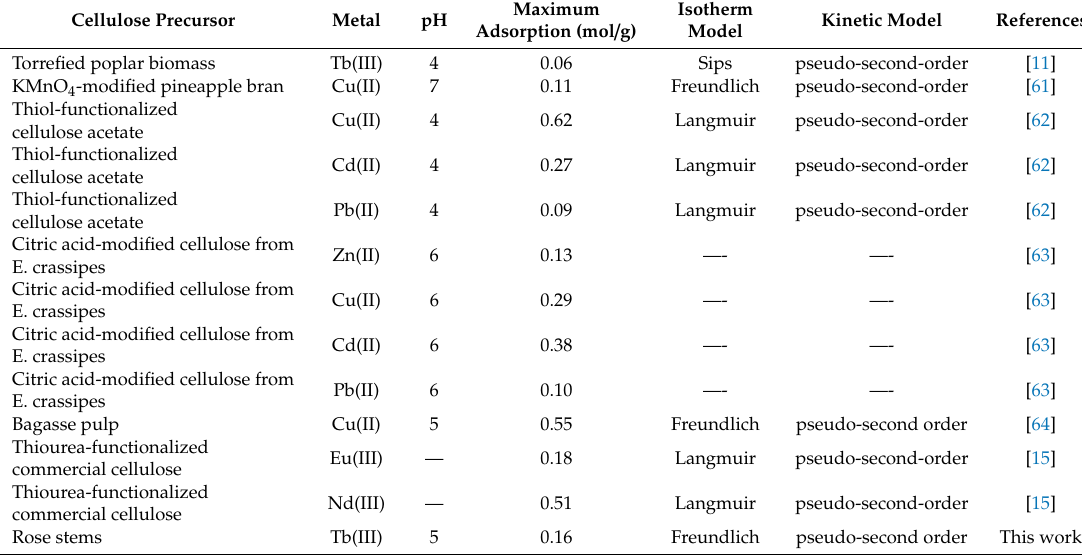
Table 2. Metal adsorption under optimal conditions for the di ff erent cellulose precursors used.